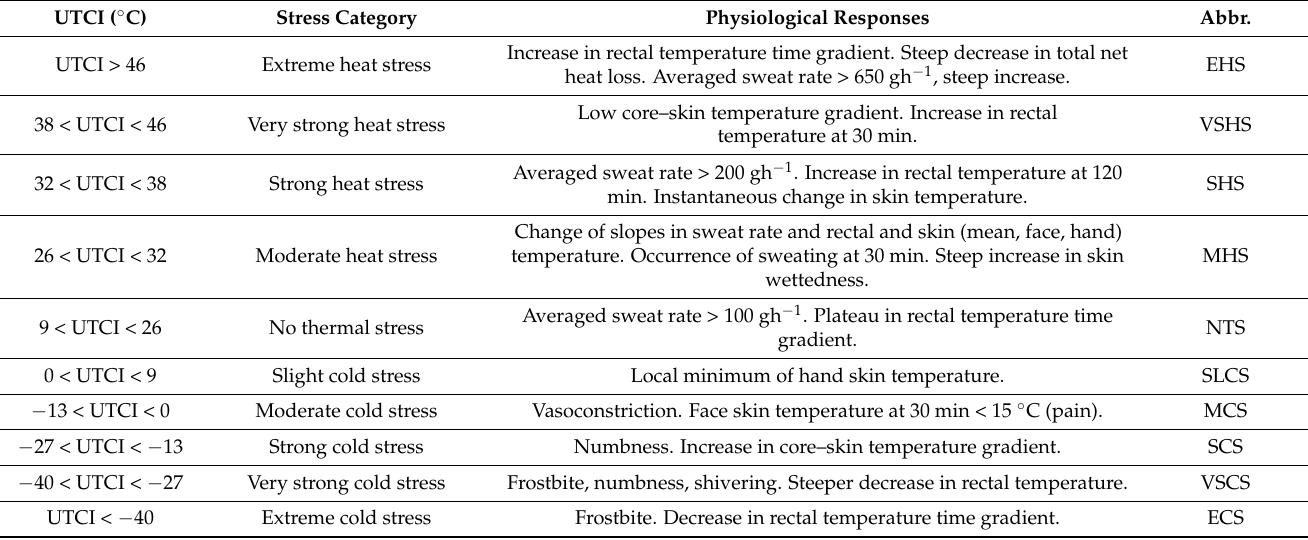
Table 1. The scale of UTCI assessment and physiological responses [67,74].